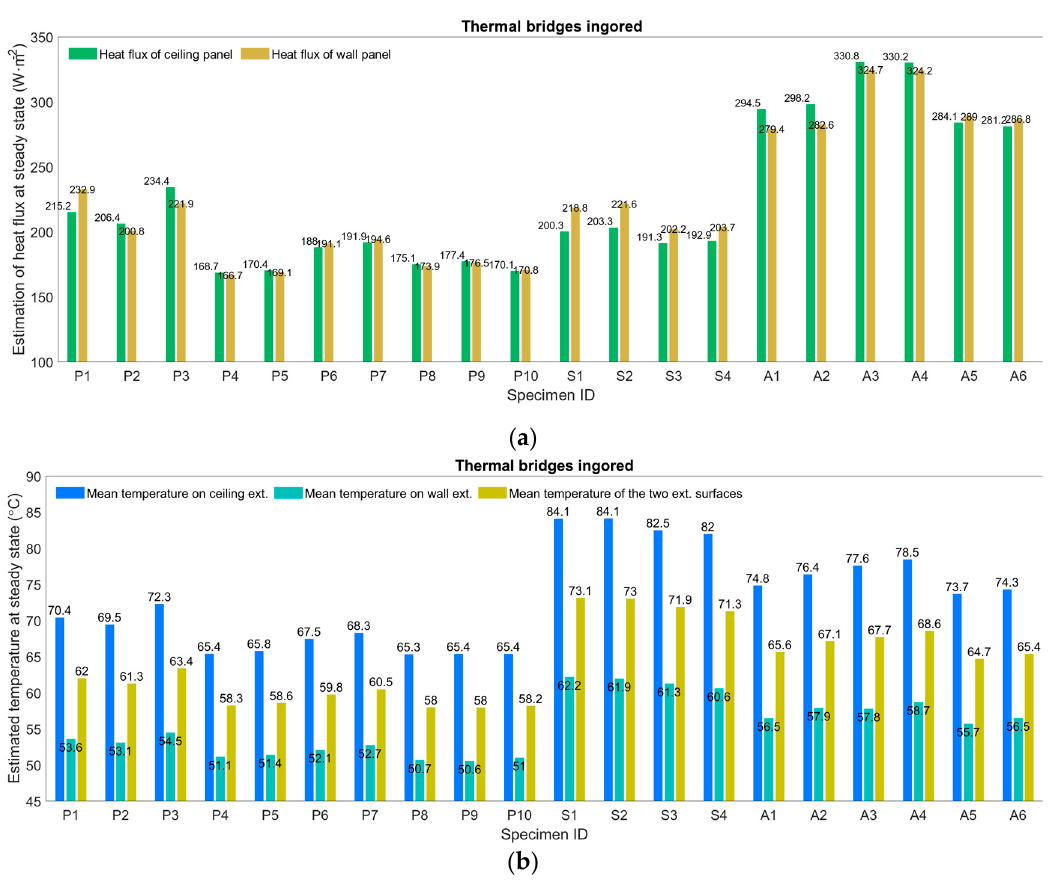
Figure 10. Estimations of ( a ) heat flux and ( b ) exterior surface temperature at a steady state.